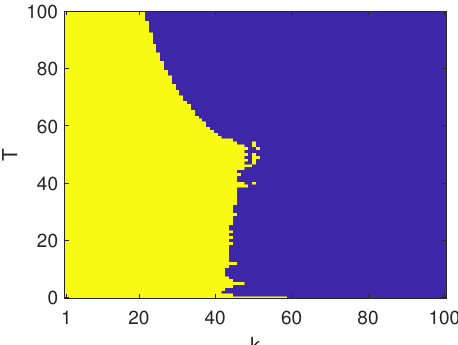
Figure 8. Numerical results: ( a ) D ( s ) = 1, C ( s ) = 100 ( s + 0.1 ) ( c ) D ( s ) = e − 100 s , C ( s ) = 10 E 1 = 5000, E 2 = 6000, η 2 = 100,000, ˜ E 1 = 5500, ˜ E 2 = 7000.